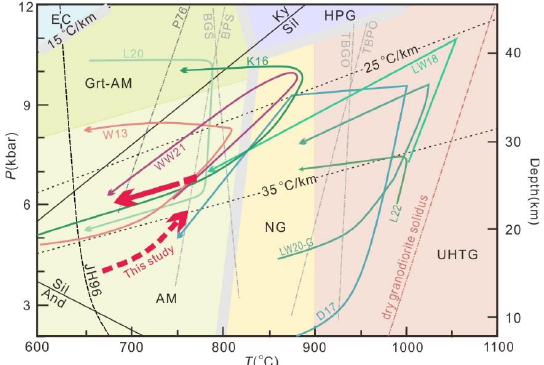
Figure 7. Summarized P – T conditions and paths for Neoarchean supracrustal rocks from the Qingyuan area, and their comparison with the metamorphic paths of supracrustal rocks from the East Hebei Terrane. Thick arrow represents the P – T path of the studied sample 15Q-4. The P – T paths from the Qingyuan area: W13, from [30] and WW21, from [28]. The P – T paths from the East Hebei terrane: D17, from [44]; K16, from [64]; LW18, from [65]; L20, from [22]; LW20-G, from meta-greywacke in [66]; L22, from [20]. BGS and BPS, and TBGO and TBPO are experimentally constrained biotite-in and -out lines for greywacke and pelite compositions from [56]. JH96 — the H 2 O-saturated granite solidus in the system Qz – Ab – Or – H 2 O [67]; P76 — experimentally constrained Ms + Ab + Qz = Sil + Kfs + Liq reaction from [59]. The dry solidus of granodiorite is from [68]. The reactions of Al 2 SiO 5 are calculated by THERMOCALC. The distributions of metamorphic facies are from [69] and abbreviations are: HPG, high- P granulite facies; NG, ‘normal’ granulite facies; UHTG, ultra-high temperature granulite facies; AM, amphibolite facies; Grt-AM, garnet amphibolite facies; EC, eclogite facies.